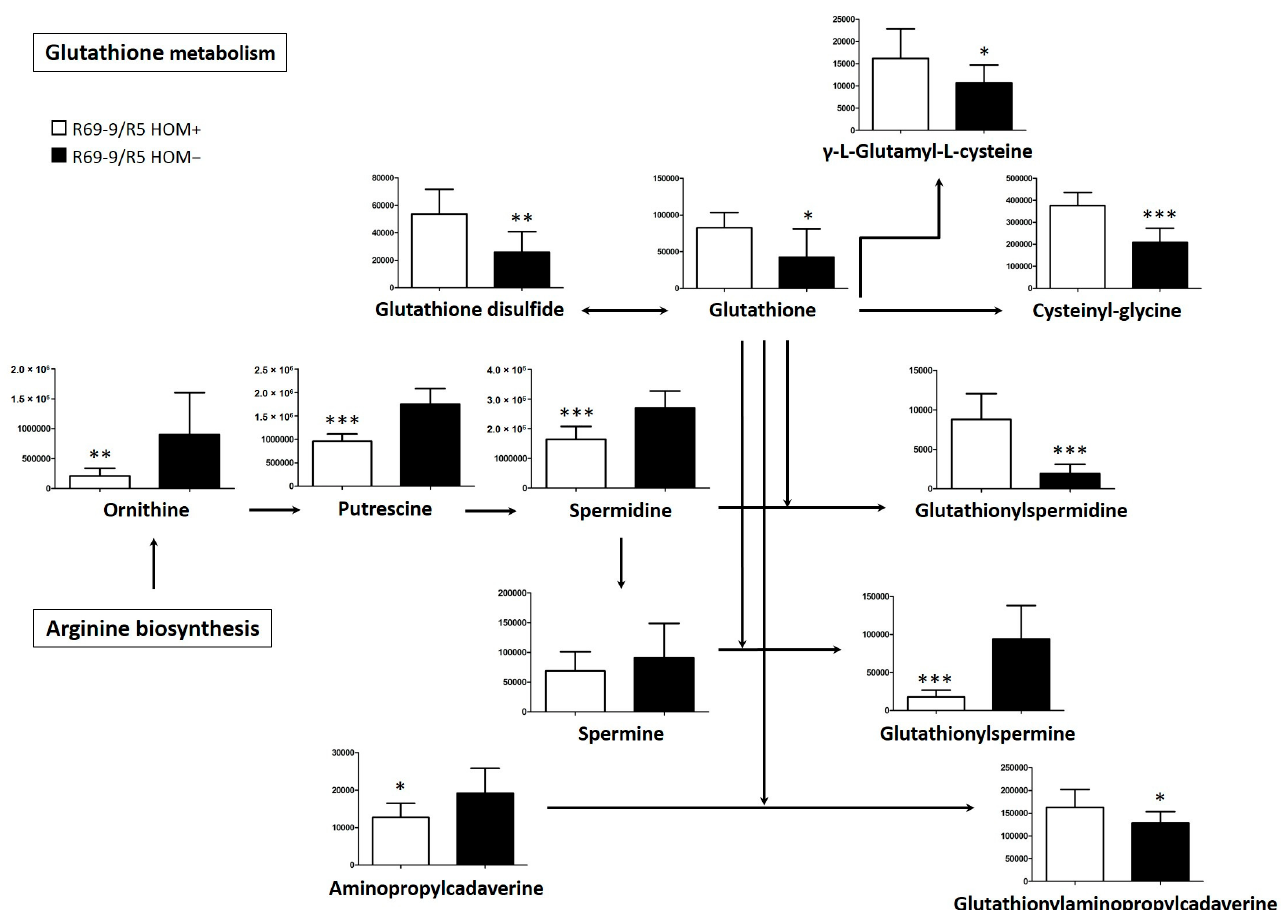
Figure 7. Significant changes in accumulation of intermediates of glutathione metabolism in rachis tissue of the resistant Fhb7E (HOM+) and susceptible (HOM − ) lines at 4 dpi ( Fg ) and their connection with the polyamine biosynthesis pathway. Values on y-axes always indicate Peak intensity of a given metabolite, while bars on histograms represent standard deviations of means. Comparison for each metabolite between the HOM+ and HOM − genotypes was analysed using Student’s t -test; *, ** and *** indicate p - values at <0.05, <0.01, and <0.001 levels of signi fi cance, respectively. Arrows indicate a direct process between molecules.